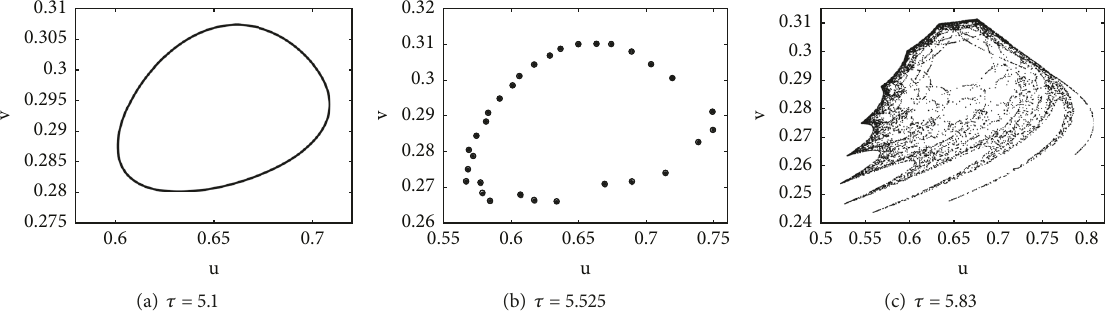
Figure 2: Three typical dynamical behaviors on the route to chaos induced by the Neimark-Sacker bifurcation, (a) invariant closed curve, (b) period-31 orbit, and (c) chaotic attractor. 𝑎 = 1.63, 𝑏 = 0.1, 𝑐 = 0.32, and 𝑑 =